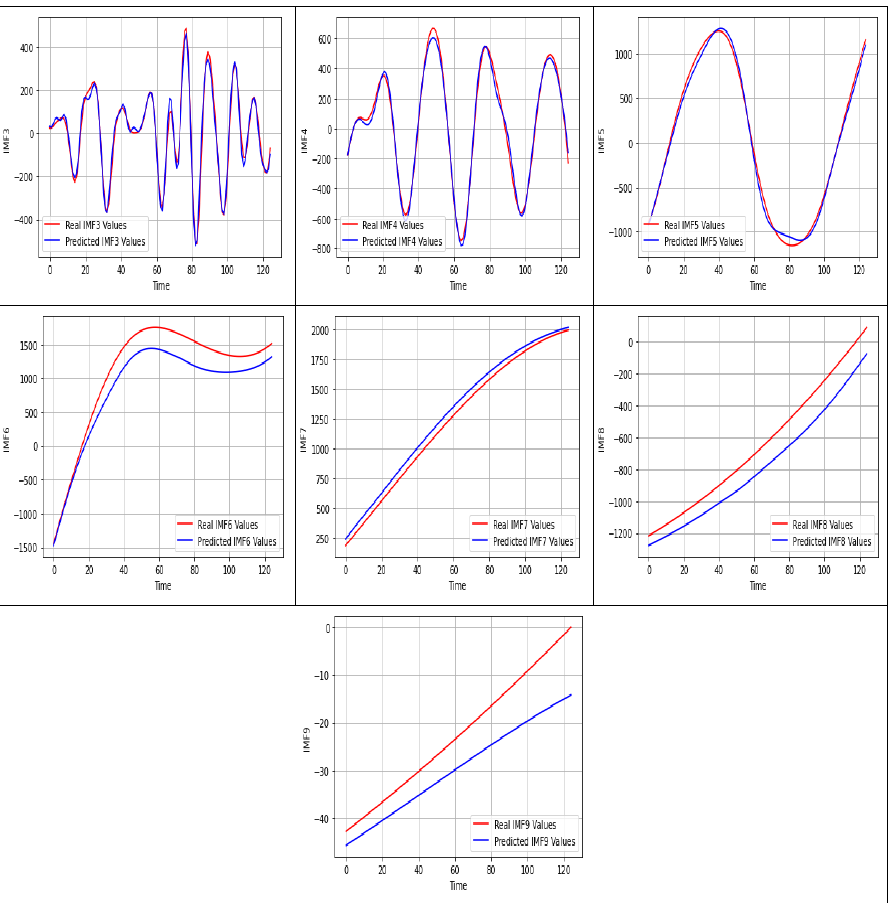
Figure 7. Predicted results of correlated subcomponents obtained from the EEMD-LSTM model.